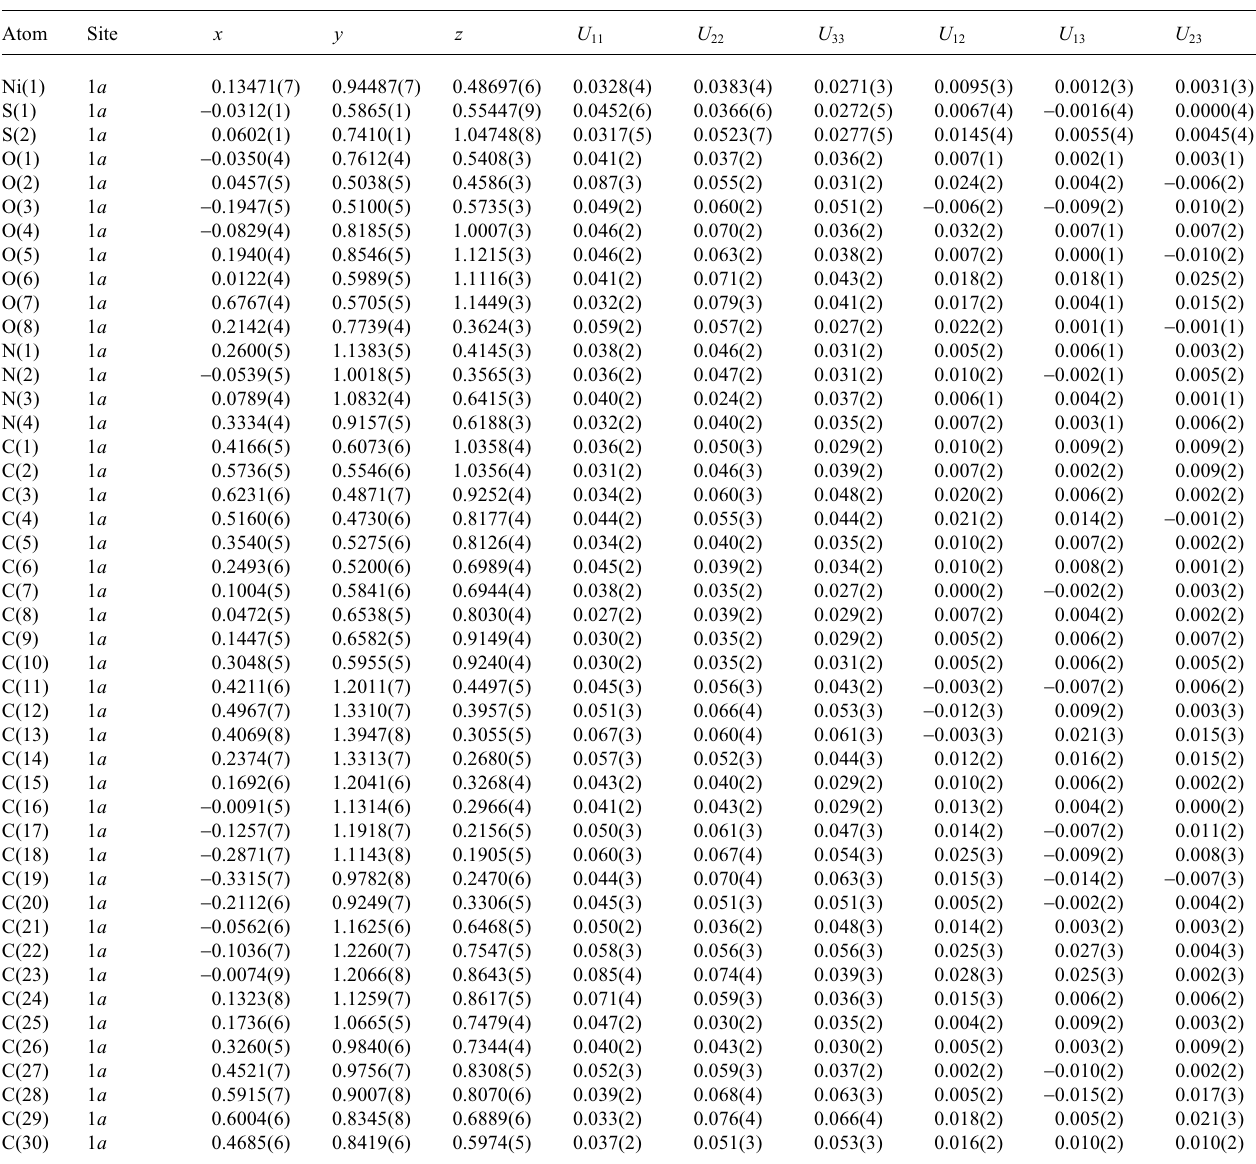
Table 3. Atomic coordinates and displacement parameters (in Å 2 ) .